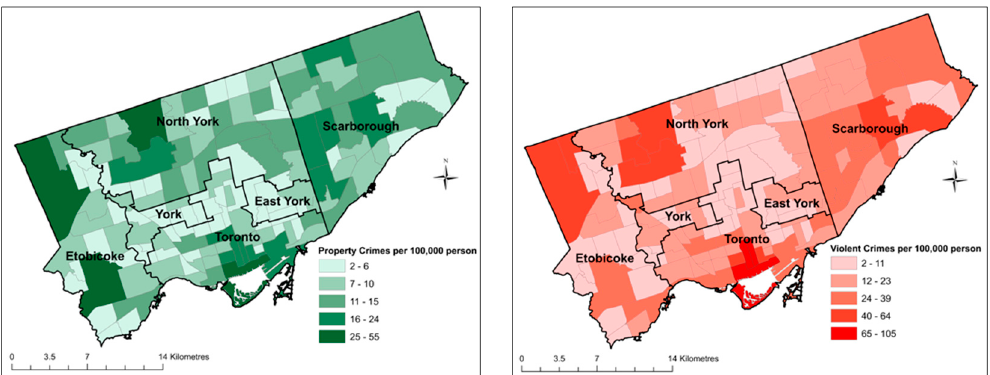
Figure 1. Property and violent crime rates (per 100,000 persons) by Toronto neighbourhood, 2014- 2016.